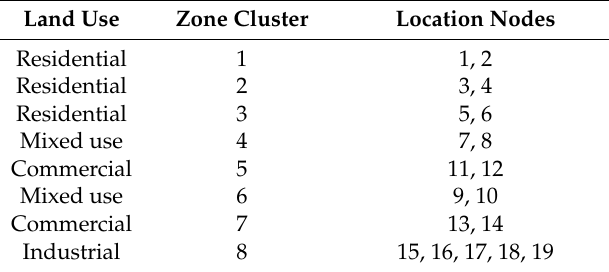
Table 1. Land-use distribution.